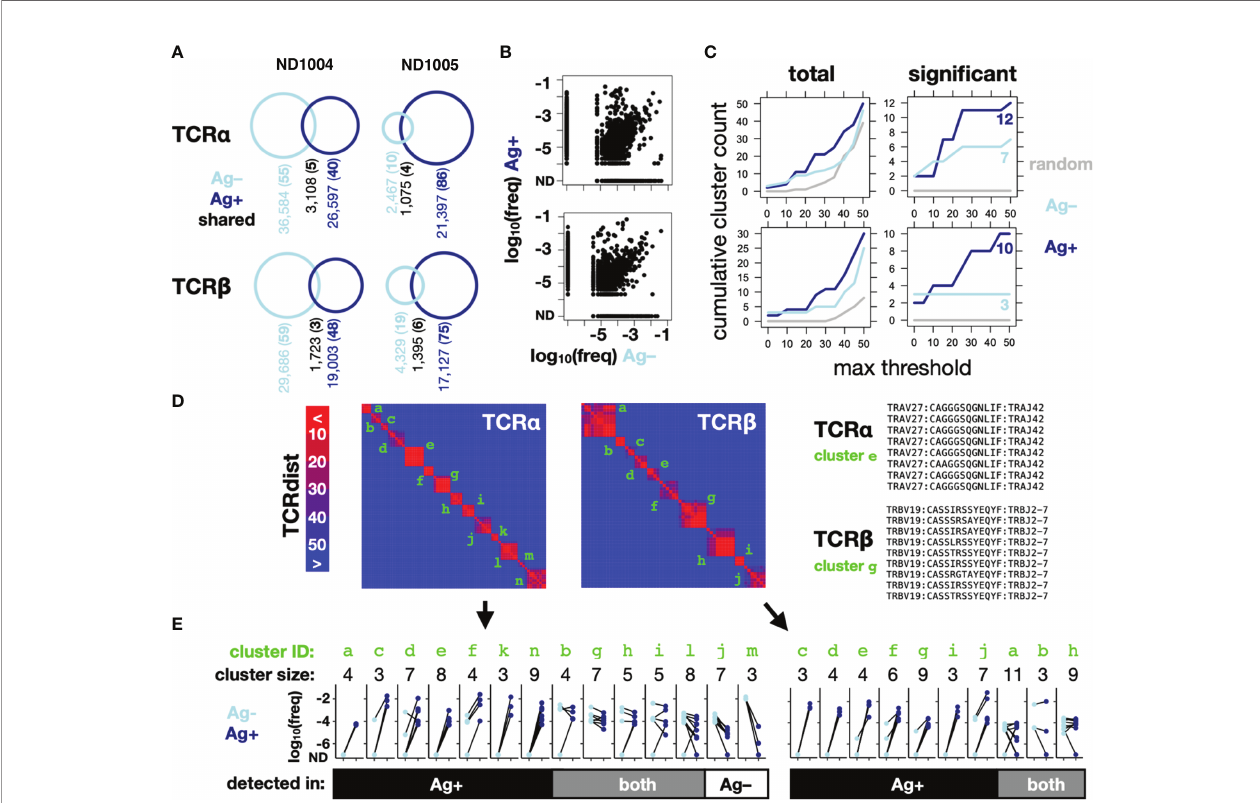
FIGURE 3 | CET analysis enables the identi fi cation of In fl uenza M1-responsive clonotypes within complex repertoires. PBMCs from 2 normal donors were cultured with IL-2 for 10 days, in the presence (Ag + ) or absence (Ag – ) of CD40-targeted In fl uenza M1 protein (as described in Figure 1), after which RNA was extracted for ampli fi cation of TCR a and TCR b chains, sequenced and analyzed using the scheme shown in Figure 2. (A) Counts of unique and shared TCR a (upper) and TCR b (lower) clonotypes across the 2 donors. The remainder of this fi gure (B – E) shows data for one representative donor (ND1005). (B) Frequencies in the Ag – and Ag+ conditions of all detected clonotypes. (C) Cumulative number of CETs – either total ( left ) or signi fi cant ( right ) – detected up to the threshold shown on the x-axis. For comparison across thresholds, clonotypes within CETs detected up to each threshold were combined and re-clustered at the maximum threshold prior to enumeration. (D) Map showing pairwise TCRdist similarities of clonotypes within signi fi cant TCR a and TCR b CETs from the analysis described in (B) Identi fi ers in green indicate CETs detected up to the maximum threshold of 50. V segment, CDR3, and J segment sequences are shown for detected clusters that correspond to a well-known HLA-A2-restricted M1 reactivity ( right ). (E) Clonotype frequencies in the Ag + and Ag – cultures for members of each of the signi fi cant TCR a and TCR b CETs. Each data point represents a single clonotype within the focal CET, and line-segments connect the same clonotype between culture